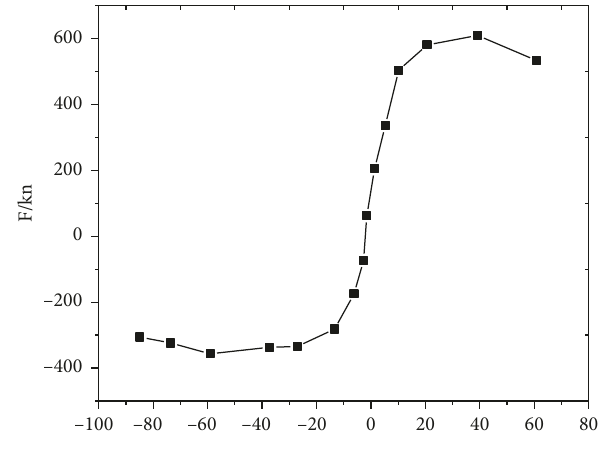
Figure 2: Skeleton curve of each specimen.